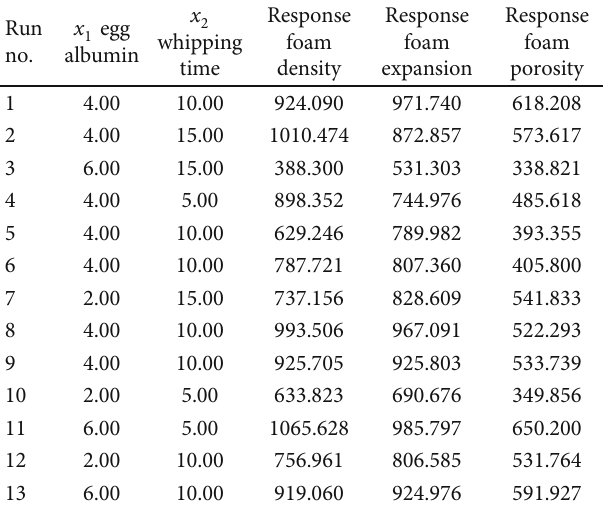
Figure 1: The combined impact of egg albumin and whipping time on foam density (a), foam expansion (b), and foam porosity (c) is depicted by a response surface plot. Table 1: Central composite face center design corresponding responses, foam density (g/cm 3 ), foam expansion (%), and foam = egg albumin (%) and x = whipping porosity (g/cm 3 ) with x 1 2 time